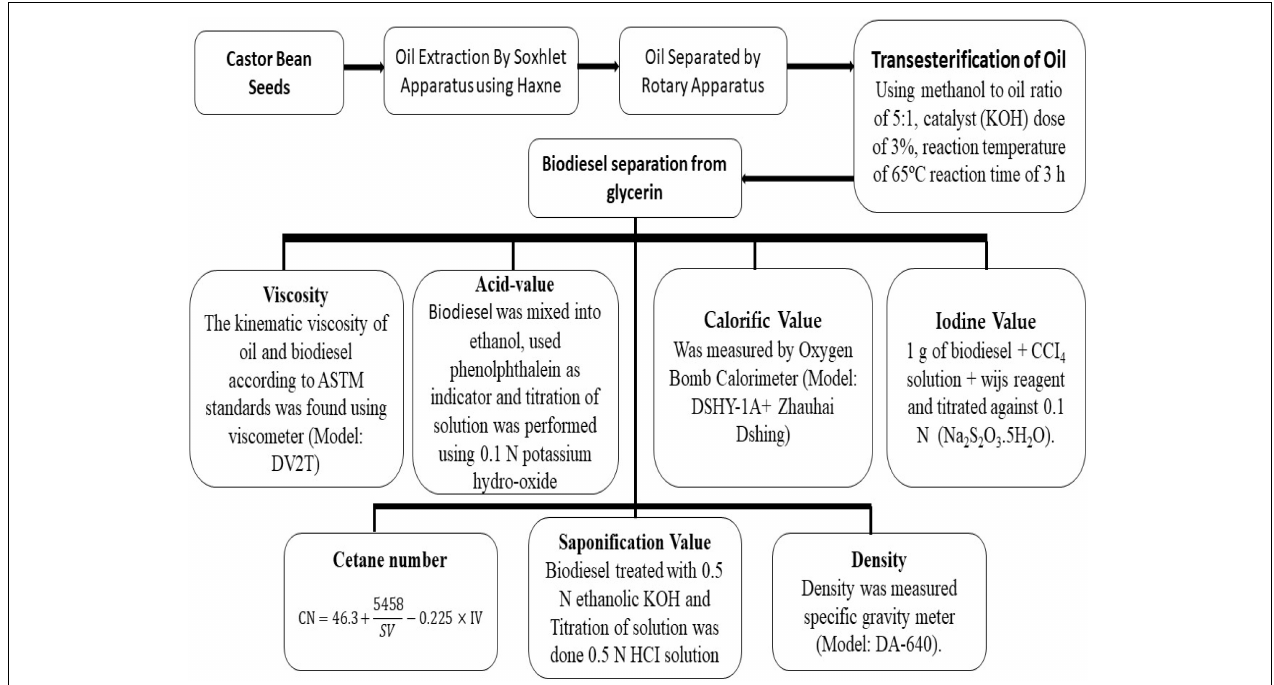
FIGURE 2 | A proposed schematic representation of complete study design and sustainable biodiesel production from castor bean.